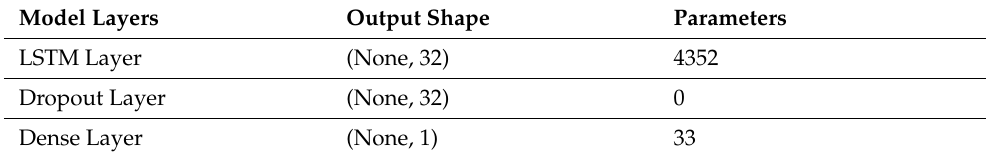
Table 3. Analysis of the architecture of the applied LSTM